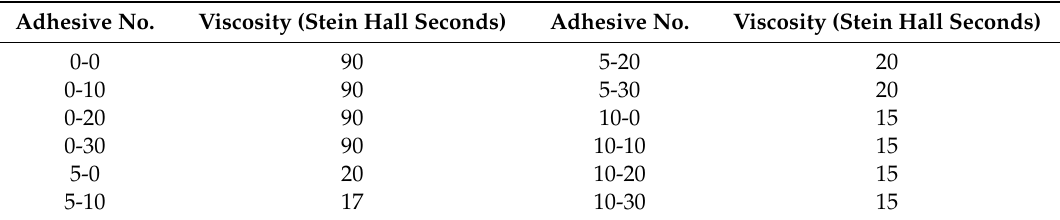
Table 4. Starch adhesive final